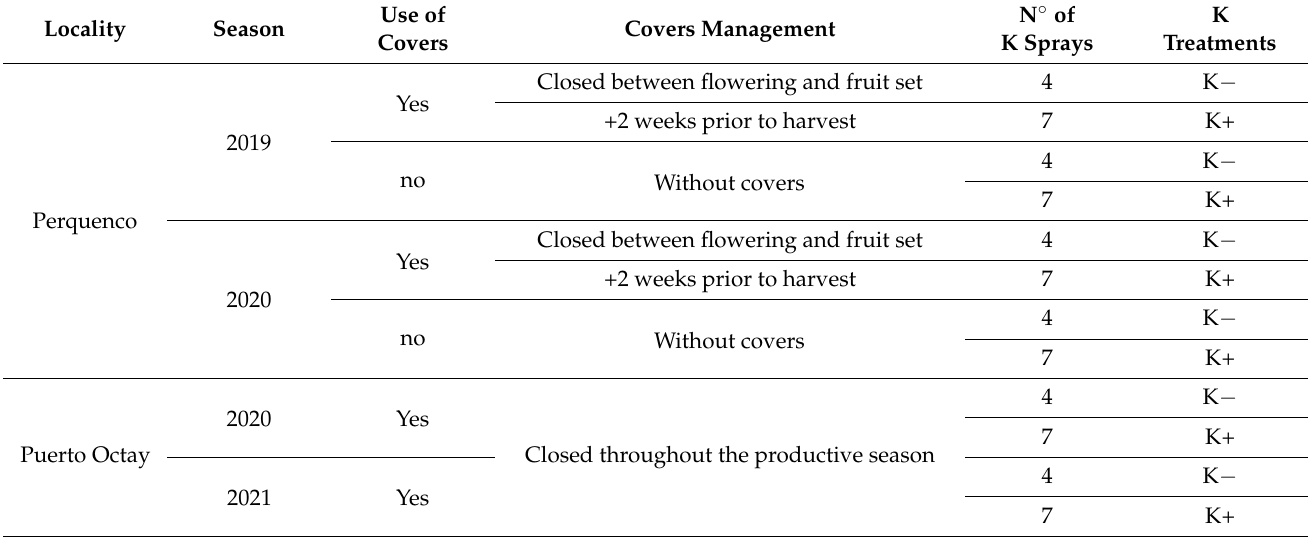
Table 4. Treatments evaluated in trees of sweet cherry (cultivar Regina) cultivated in two commercial orchards of southern Chile (Perquenco and Puerto Octay), subjected to two foliar potassium (K) treatments: conventional K regime (4 sprays during the season: K- treatment) or intensive K regime (7 sprays during the season; K+ treatment). In each location, the assays were conducted in two consecutive seasons. In the Perquenco orchard, covered and un-covered trees were compared. Locality